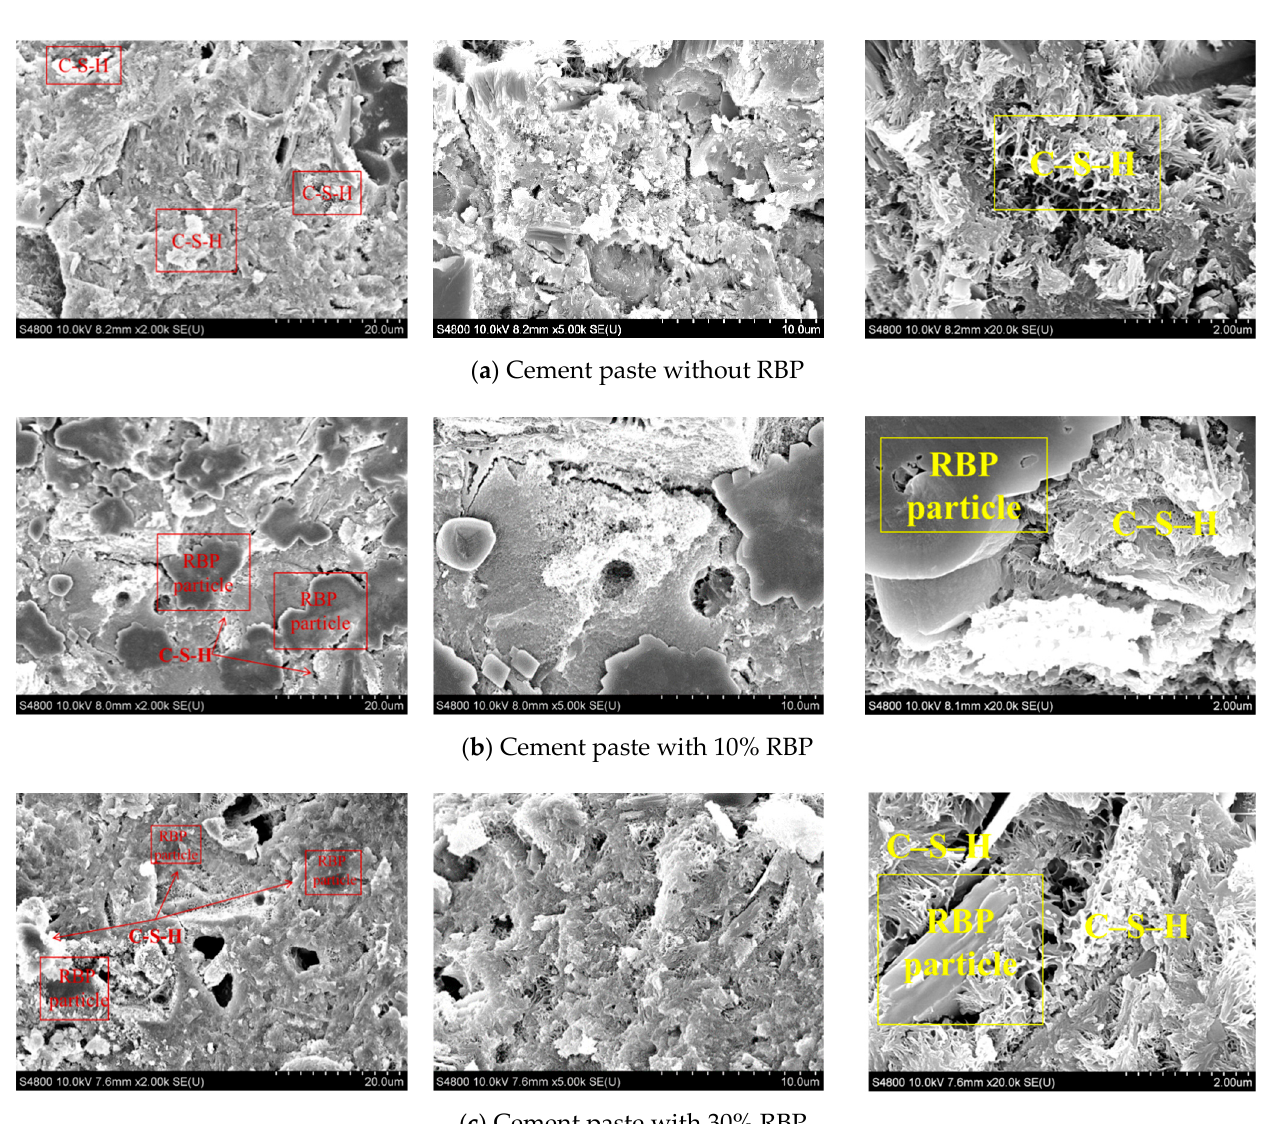
Figure 7. SEM results of cementitious materials with various RBP contents.